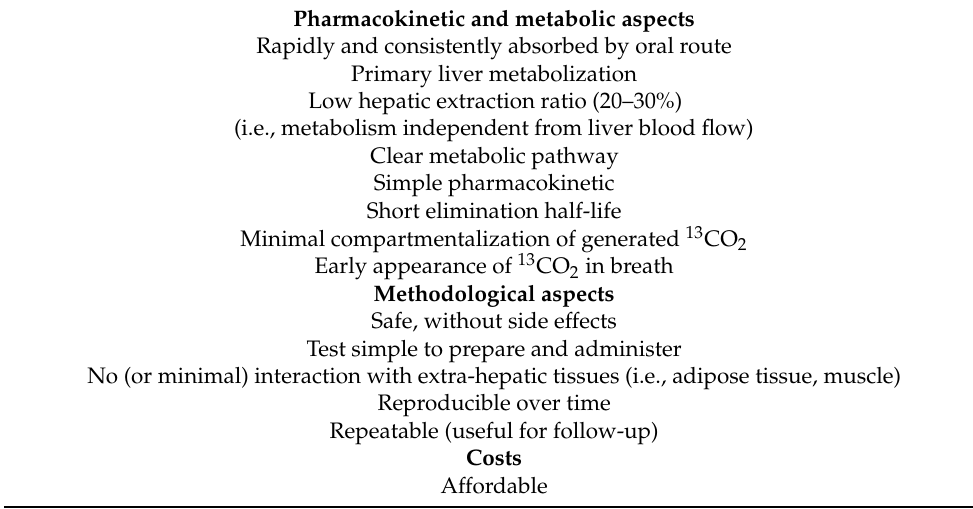
Table 1. General characteristics of an ideal substrate for studying dynamic liver function